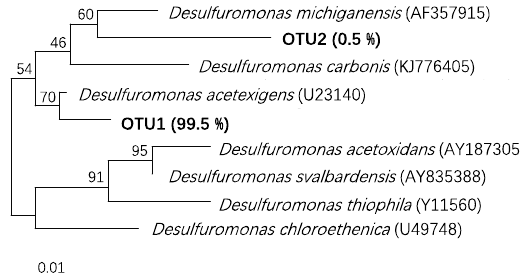
Figure 7. Phylogenetic tree of similarity between OTUs obtained in this study and different Desulfuromonas species. The tree was calculated using the neighbor-joining method. The percentages indicate the number of reads assigned to the OTUs for that assigned to the genera Desulfuromonas in the communities. The number of bootstrap replications was 1000. The bar indicates the difference of the genome sequences.